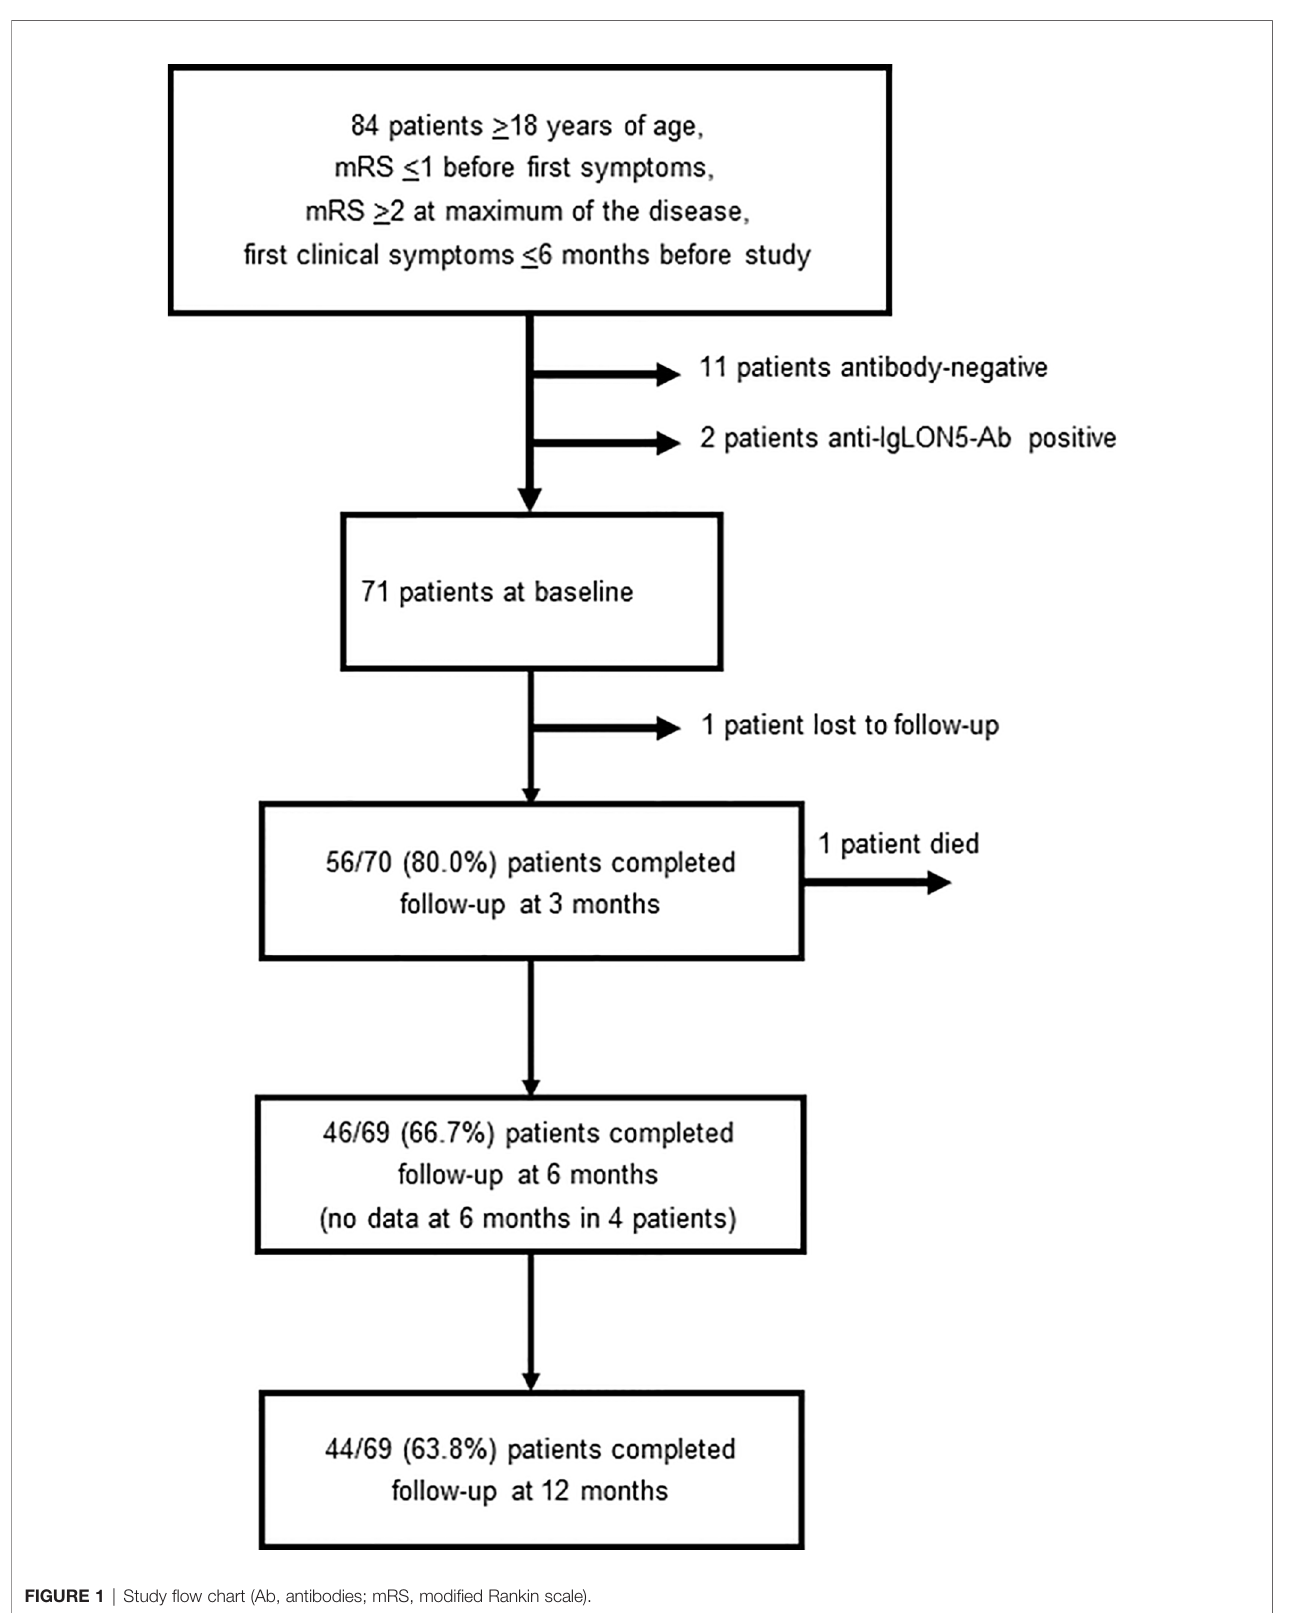
FIGURE 1 | Study fl ow chart (Ab, antibodies; mRS, modi fi ed Rankin